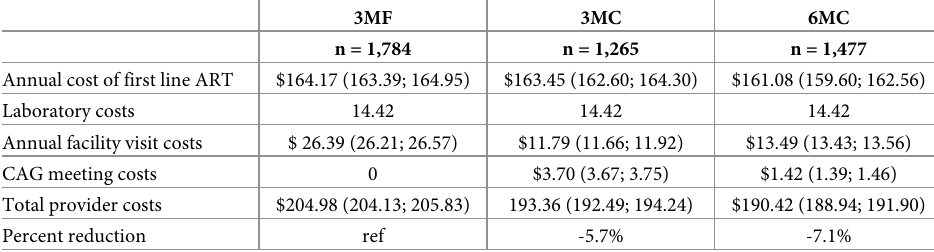
Table 4. Provider cost breakdown for those retained if all patients who were retained in care received viral load testing.